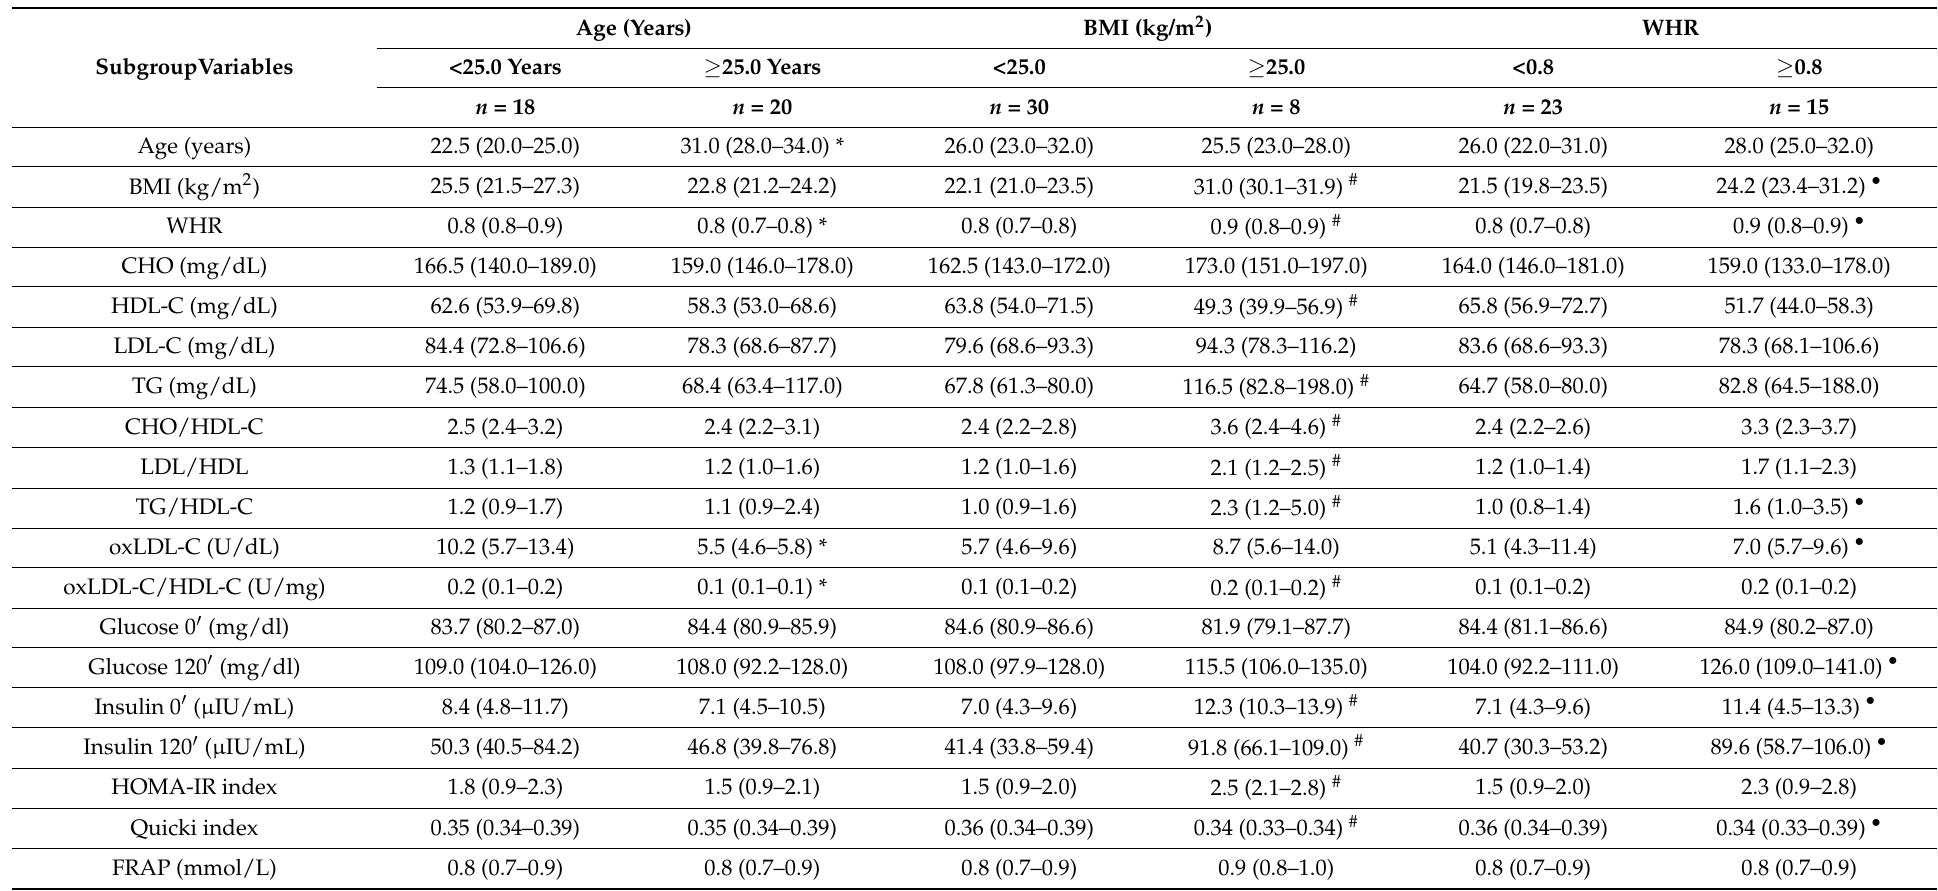
Table 1. Examined parameters in PCOS women divided according to age, BMI and WHR